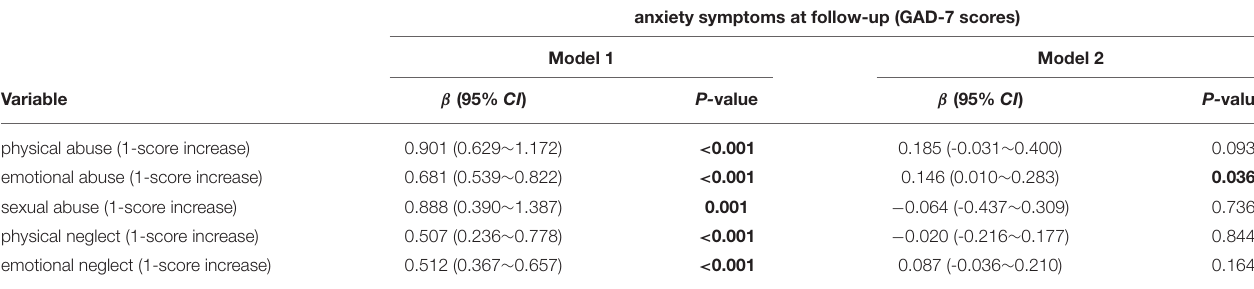
TABLE 2 | Association of childhood maltreatment with anxiety symptoms at